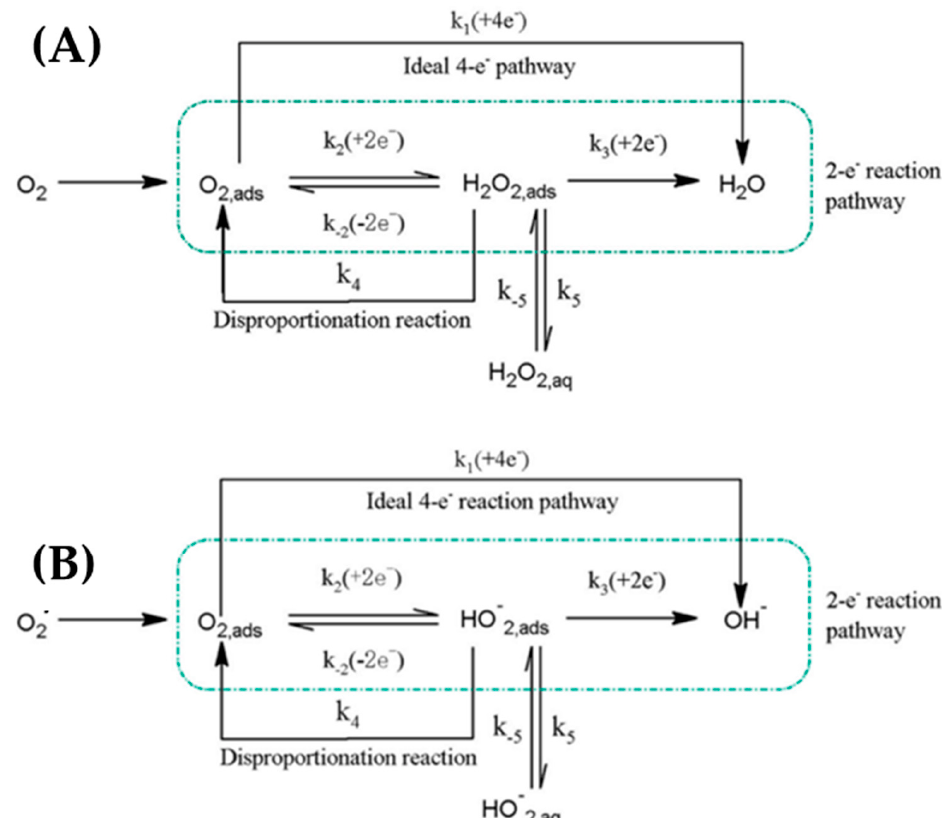
Figure 21. Simplified ORR mechanism through direct 4e − reduction or two steps. ( A ) peroxide pathways on acidic and neutral dielectrics and ( B ) intermediate pathways in alkaline dielectric. Adapted from [114] with permission. Table 3. Overall reaction equations of ORR in acidic and alkaline